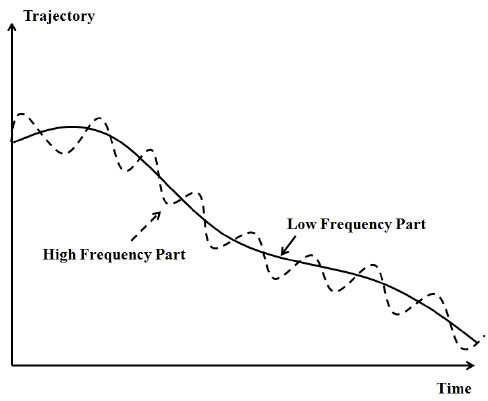
Figure 2. The mobility model of drifted